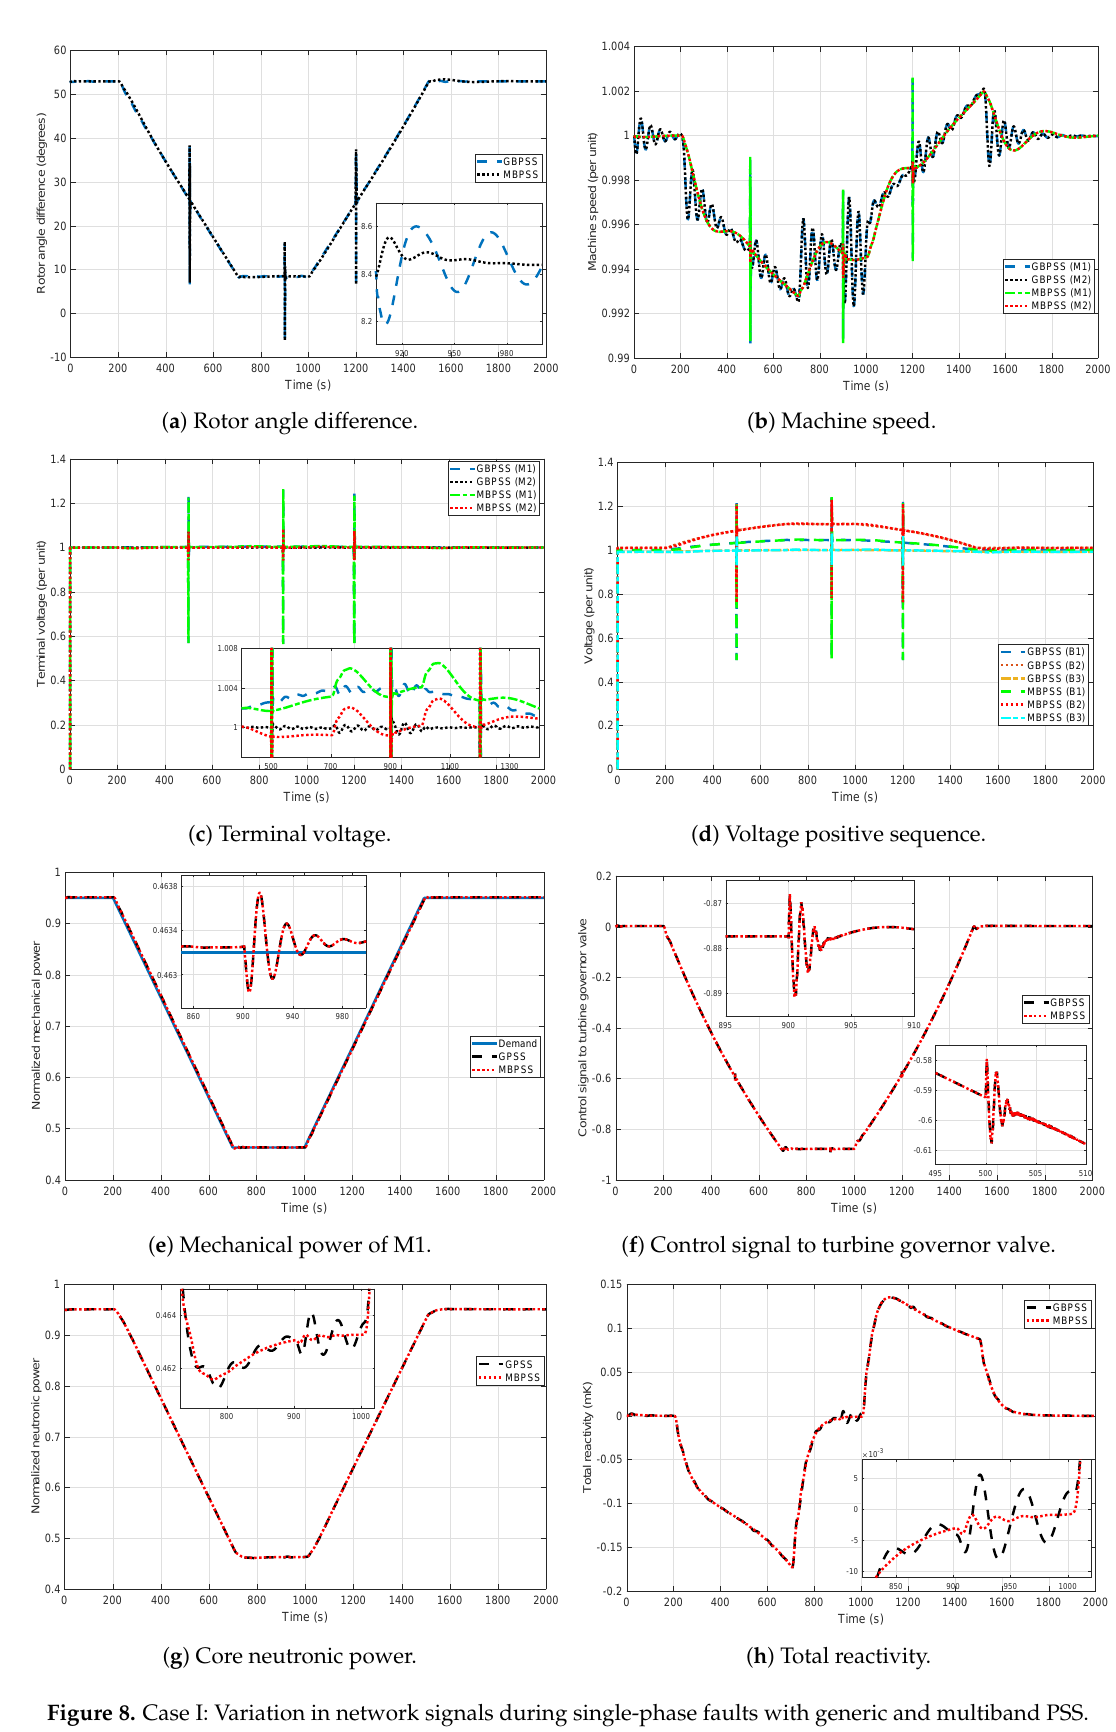
Figure 8. Case I: Variation in network signals during single-phase faults with generic and multiband